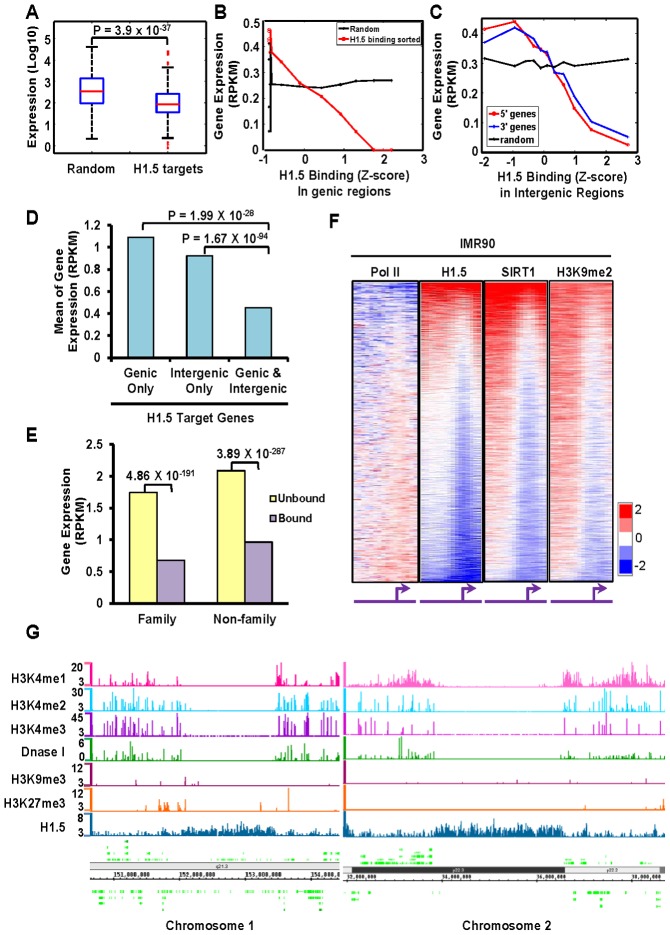
H1.5 is associated with repressed genes.(A) Boxplots of expression levels (Affymetrix array) of randomly selected genes (left) and H1.5 target genes (right) in IMR90 fibroblasts. (B–C) Line charts show gene expression levels (mRNA-seq) as a function of H1.5 binding at (B) genic regions or (C) intergenic regions in control knockdown IMR90 fibroblasts. All RefSeq genes were sorted by H1.5 binding levels; each data point represents the average expression value of 2000 genes. Genes located upstream or downstream of an intergenic region were denoted as 5′ gene (red line) and 3′ gene (blue line), respectively. (D) Average expression level of genes bound by H1.5 at either genic (left), intergenic (middle), or both (right) regions in IMR90 fibroblasts. Wilcoxon rank sum test p-values are indicated. (E) Average expression level of genes that belong (‘family’) or do not belong (‘non-family’) to HGNC gene families that were bound (purple bars) or not bound (yellow bars) by H1.5 in IMR90 fibroblasts. (F) Genome-wide promoter binding of Pol II, H1.5, SIRT1 and H3K9me2 in IMR90 fibroblasts. (G) Distributions of H3K4me1, H3K4me2, H3K4me3, DNase I sensitive sites, H3K9me3, H3K27me3, and H1.5 peaks at LCE/SPRR/S100A gene cluster (left panel) and an intergenic region in chromosome 2 (right panel). The scale of DNase I hypersensitive sites represent z-score of counts in each 100-bp window. Scales of H1.5 and other histone modifications represent the Poisson p-values of enrichment at each 100-bp window.